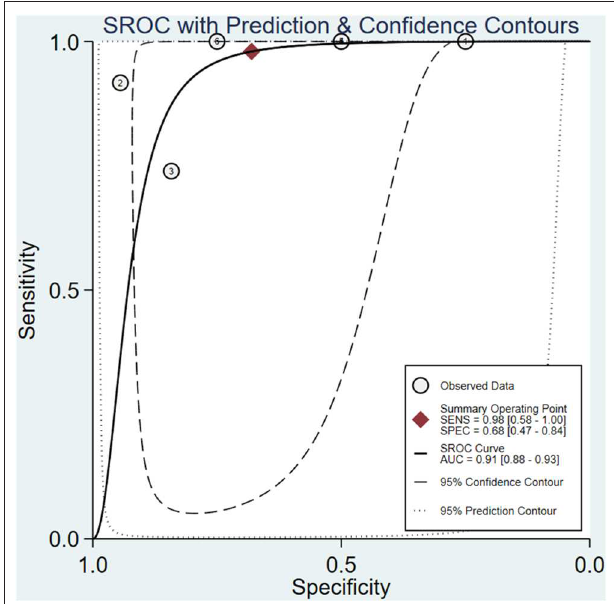
FIGURE 3 | Summary receiver operating characteristic plot for the uptake change ratio of 99m Tc-MIBI scintigraphy in preoperatively assessing the response of osteosarcoma patients to neoadjuvant